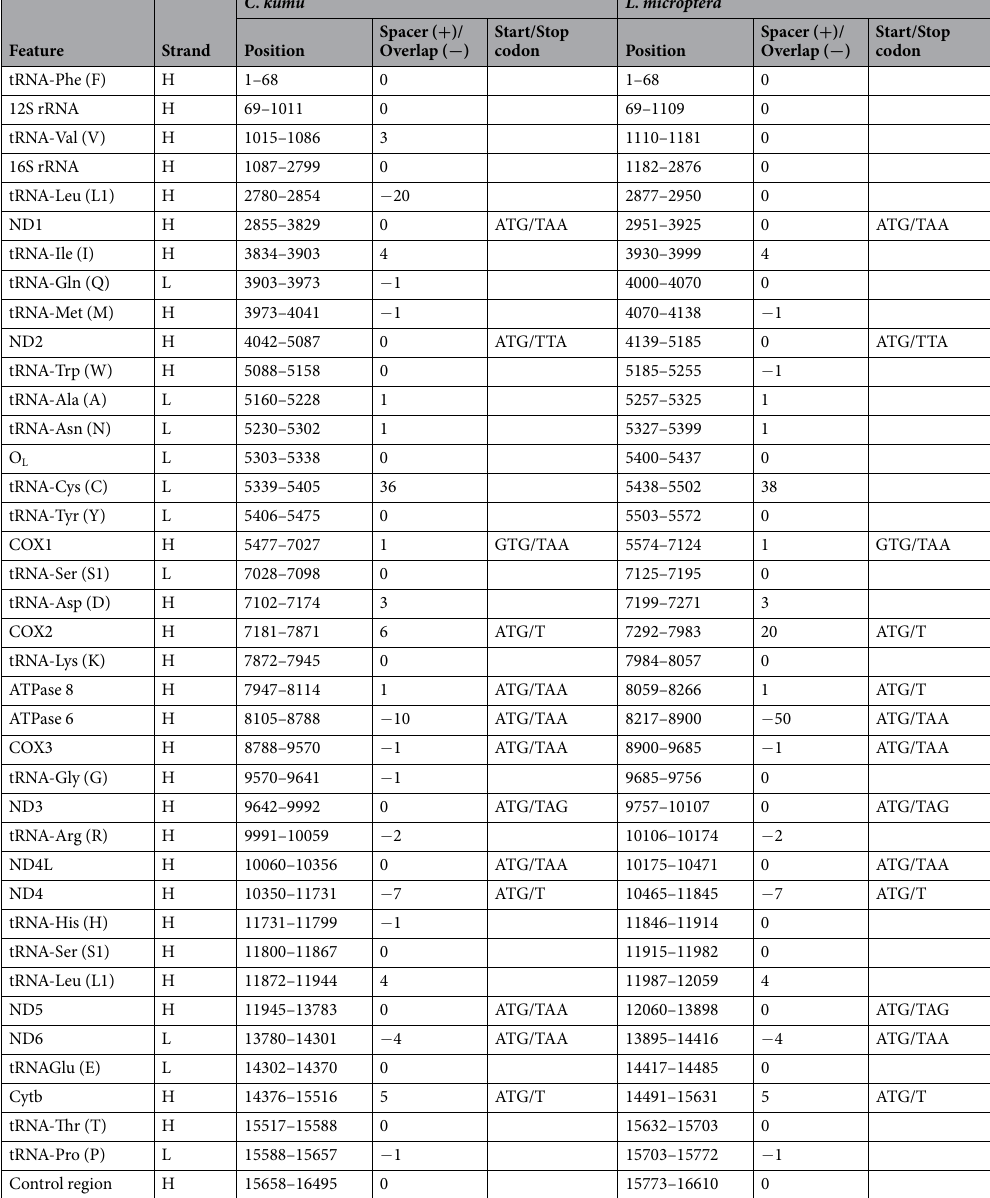
Table 2. Mitochondrial genome organization of C. kumu and in L. microptera . * H and L refer to the heavy and light strand,